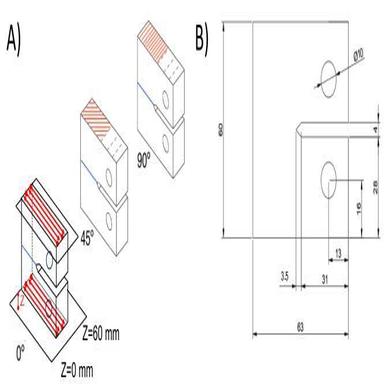
A) AM Layer Orientation Angle (Red lines are layer orientation, blue lines are crack planes) and B) geometry of the CT Specimen Manufacturing.